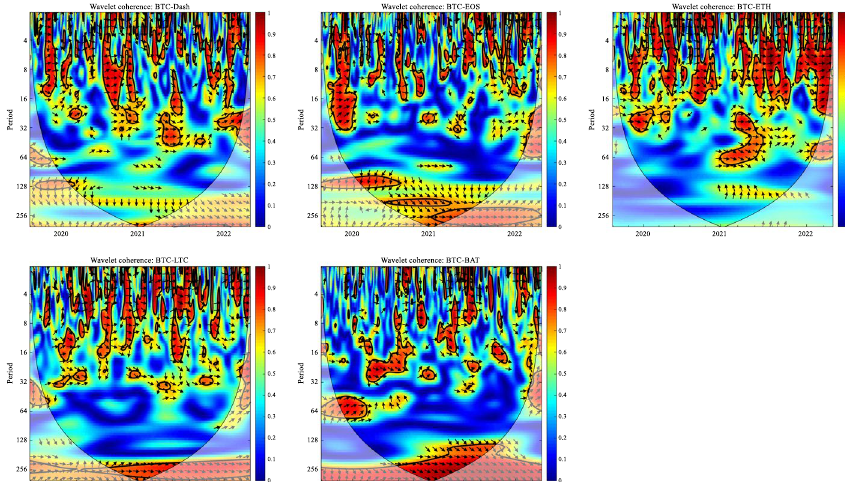
Fig. 6 Wavelet coherence—signed jump variation